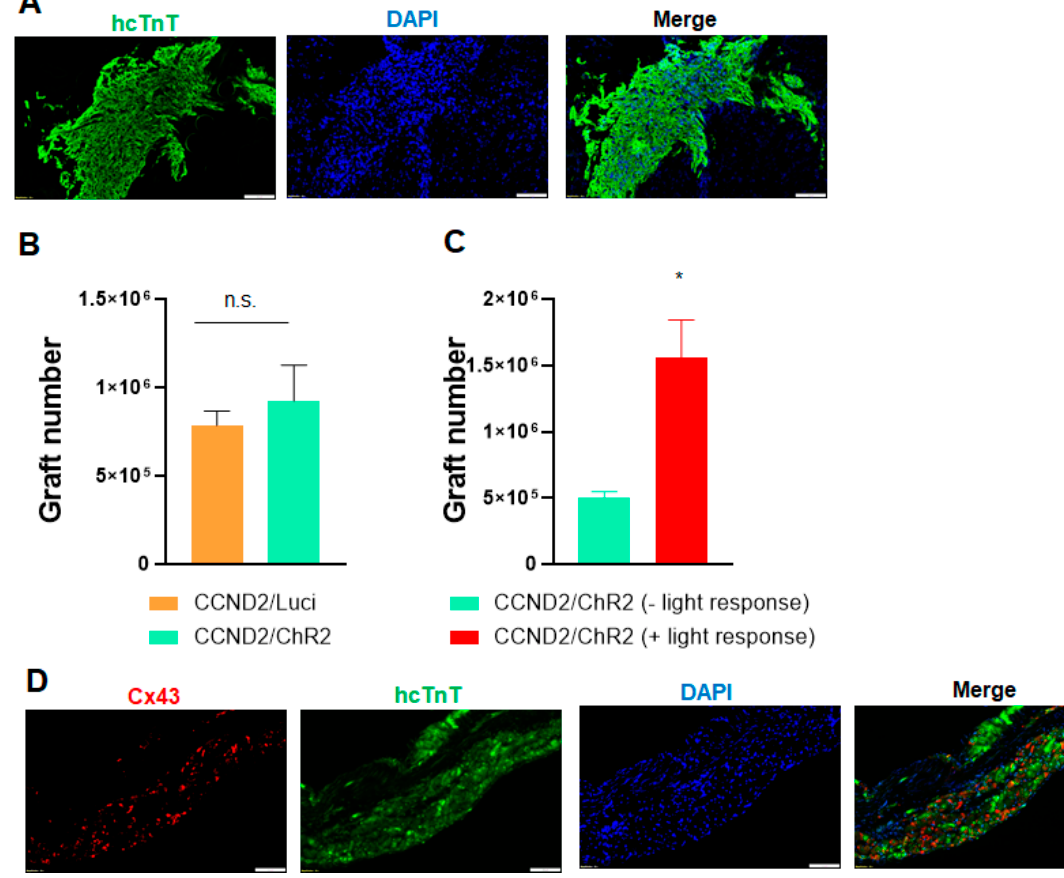
Figure 6. Immunohistological analysis of engrafted hiPSC-CMs. ( A ) Heart sections from light-responsive mice that had been sacrificed 6 months after myocardial infarction induction and treatment with PBS and hiPSC-CMs were stained for the presence of hcTnT. Nuclei were counterstained with DAPI. Scale bar = 100 μ m. ( B – C ) The engraftment rate was calculated by dividing the number of cells that expressed hcTnT by the total number of cells administered and expressed as a percentage. *— p < 0.05 versus mice receiving hiPSC-CCND2 OE /ChR2 OE CMs but not responsive to light; Student’s t-test. n = 10 mice in hiPSC-CCND2 OE /Luci OE CMs group; n = 10 mice in hiPSC-CCND2 OE /ChR2 OE CMs group (n = 6 not responsive to light and n = 4 responsive to light). n.s. indicates no significant difference. ( D ) Engrafted hiPSC-CCND2 OE /ChR2 OE CMs were identified in mouse hearts at 6 months after myocardial infarction induction and cell transplantation via im- munofluorescent staining for the expression of human cTnT. Both transplanted cardiomyocytes and native cardiomyocytes were stained with antibodies against Connexin-43. Images were from heart sections of light-responsive mice. Scale bar = 100 µ